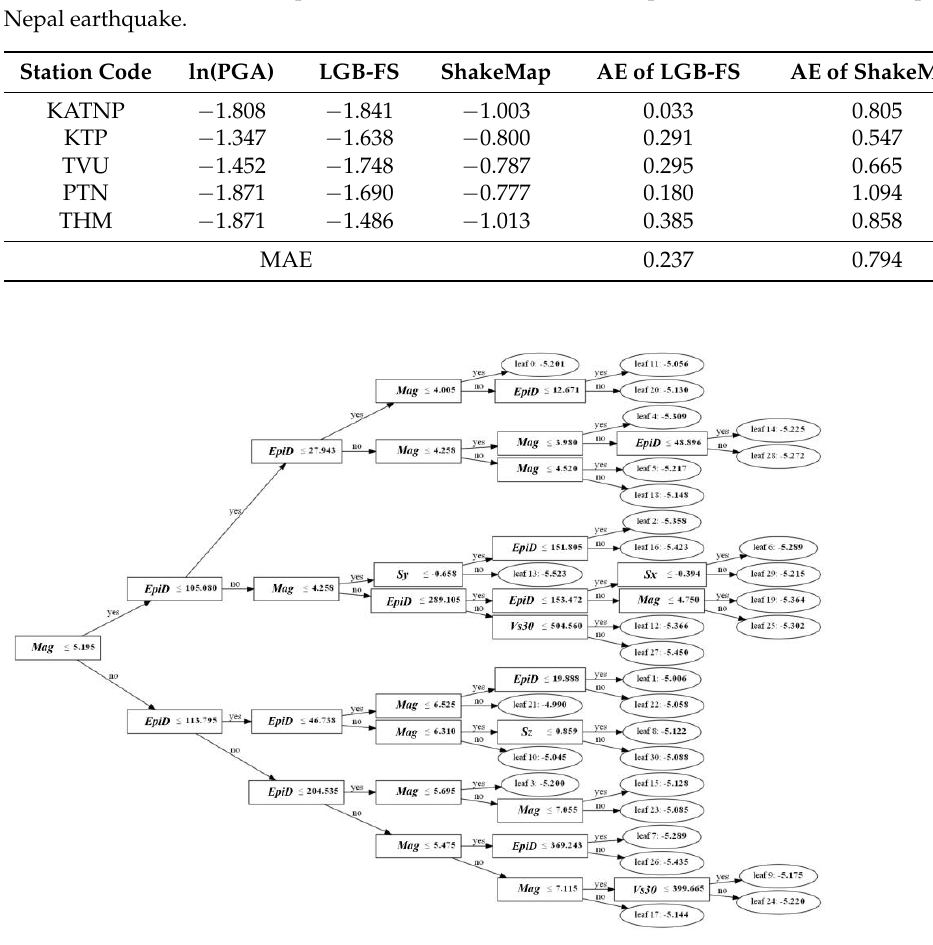
Figure 5. A tree of PGA prediction model. Rectangles represent feature segmentation nodes, and ellipses represent leaf nodes.